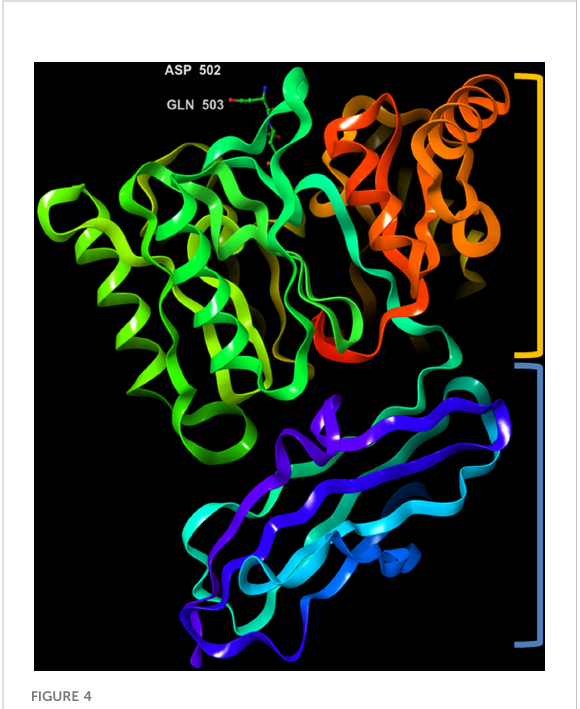
FIGURE 4 3D representation of Porphyromonas gingivalis PPAD with co- crystallized ligand, Asp-Gln dipeptide (substrate-mimic complex) (PDB ID: 4YTB). Highlighted in orange: crown (catalytic domain), blue: root (IgSF domain).